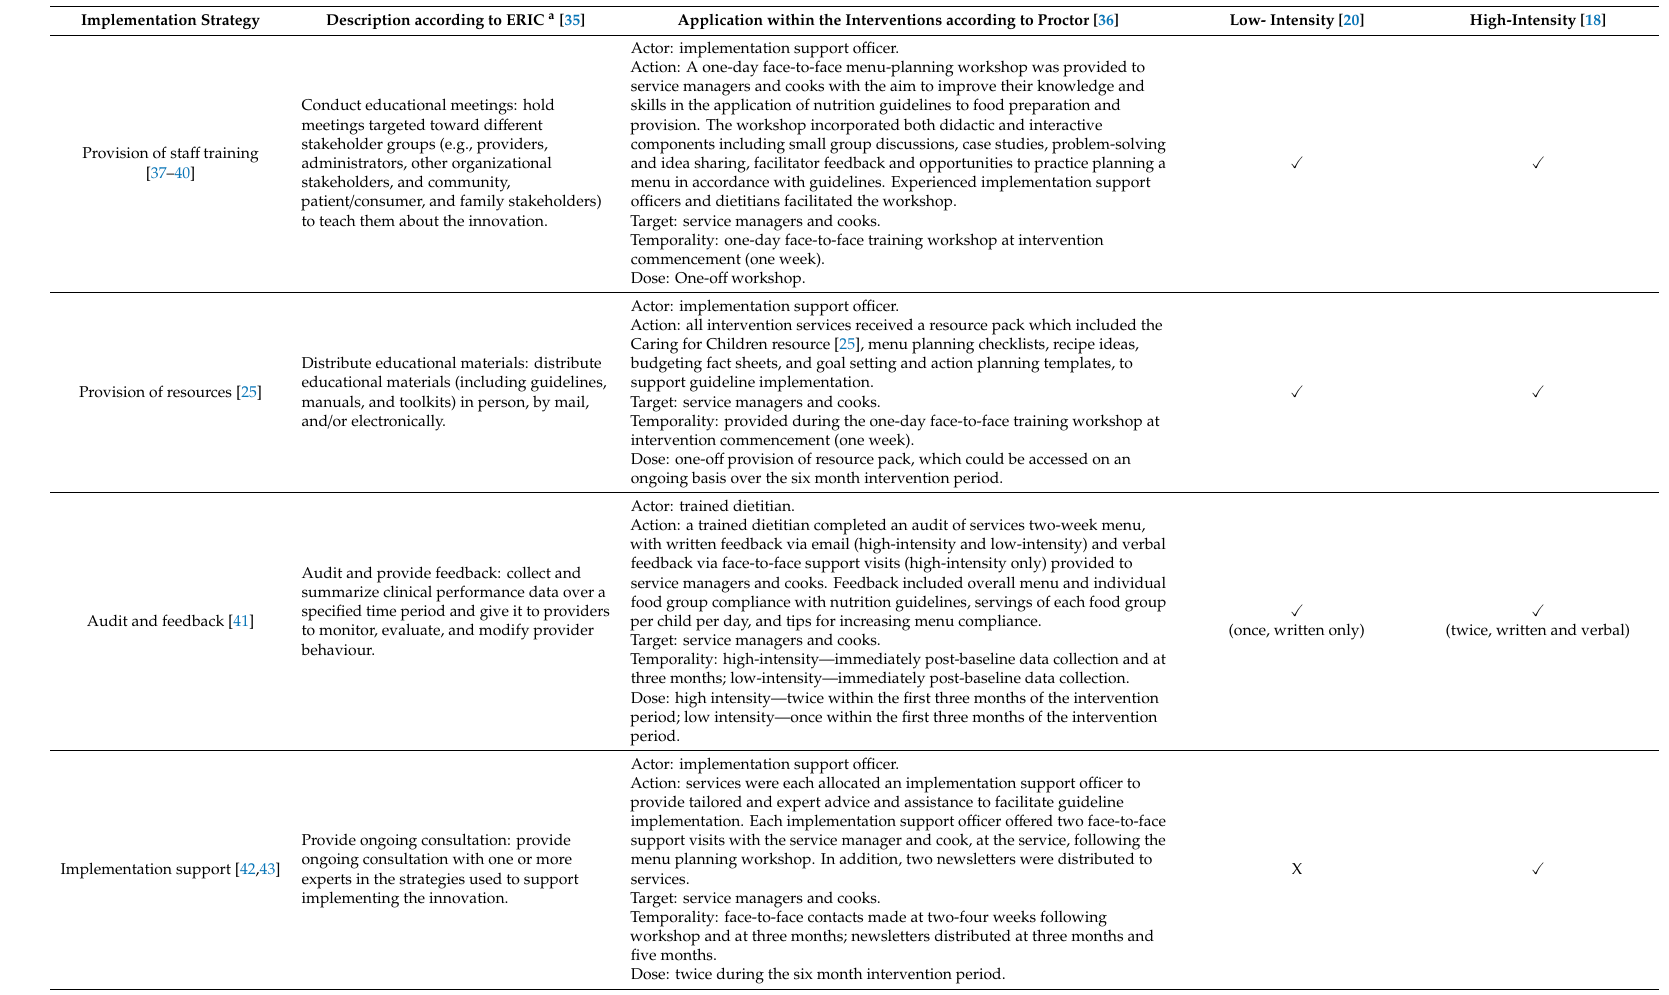
Table 1. Summary of the high- and low-intensity implementation